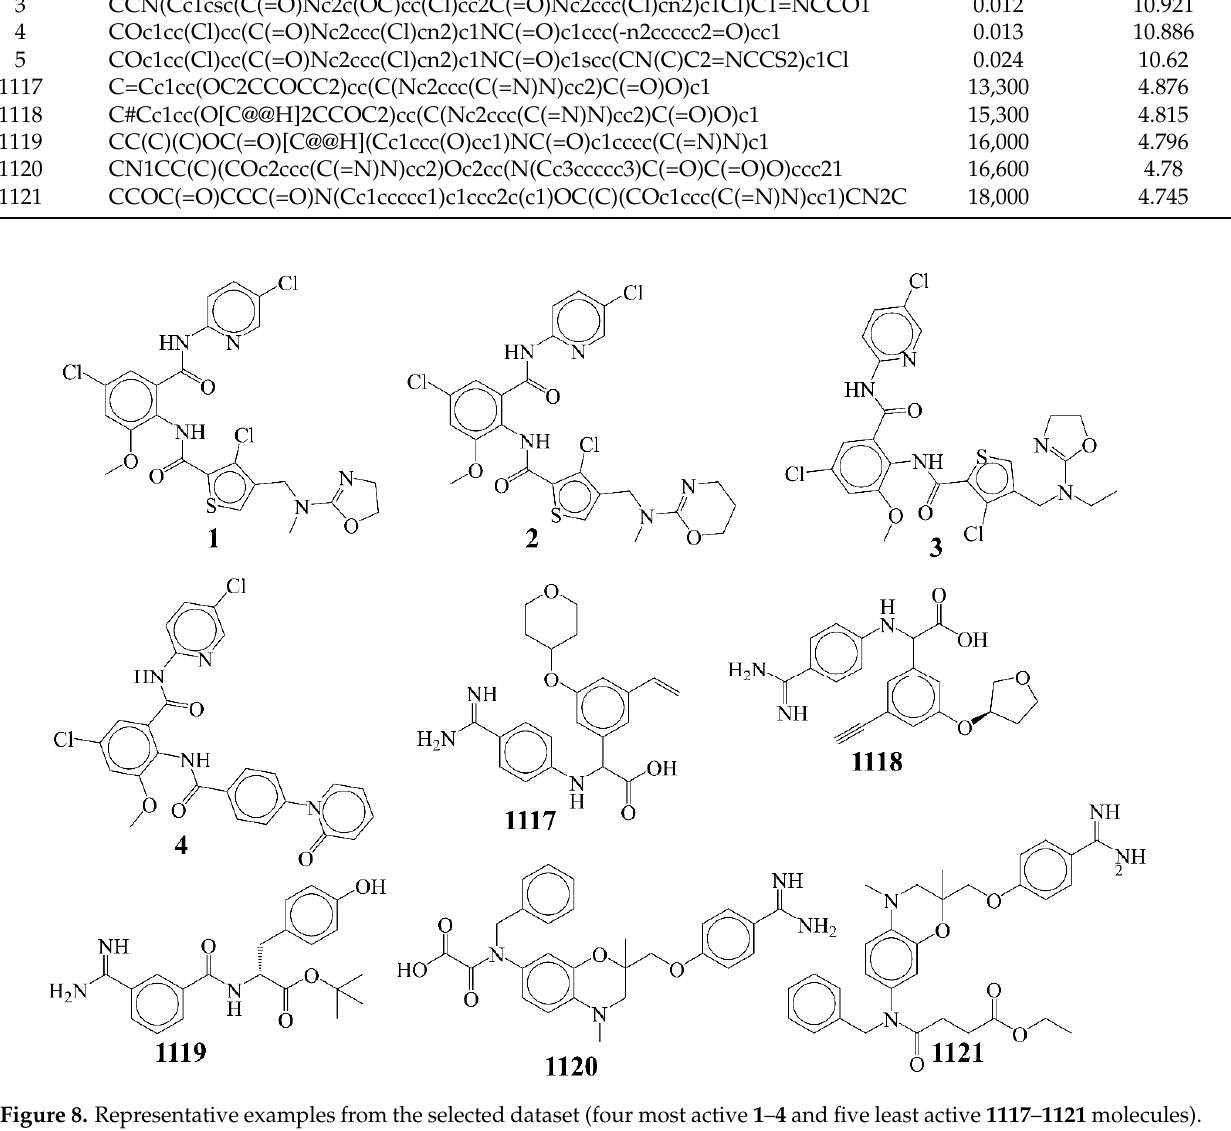
Figure 8. Representative examples from the selected dataset (four most active 1 – 4 and five least active 1117 – 1121 mole- cules).